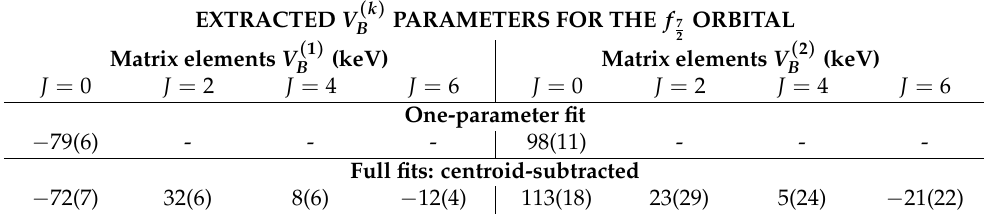
( 1 ) ( J ) and isotensor V ( 2 ) ( J ) INC matrix B B